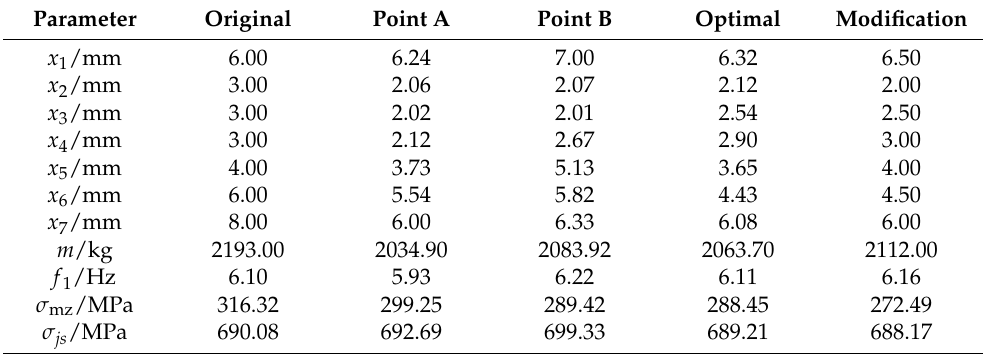
Table 7. Comparison among the original model and optimized models of the